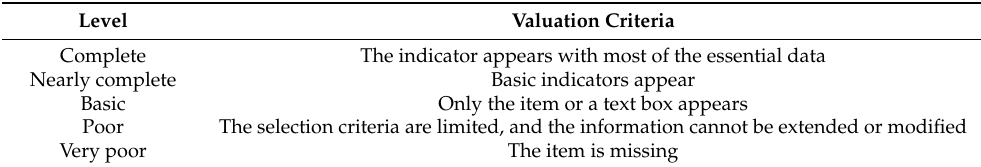
Table 1. Levels and requirements to apply a Likert